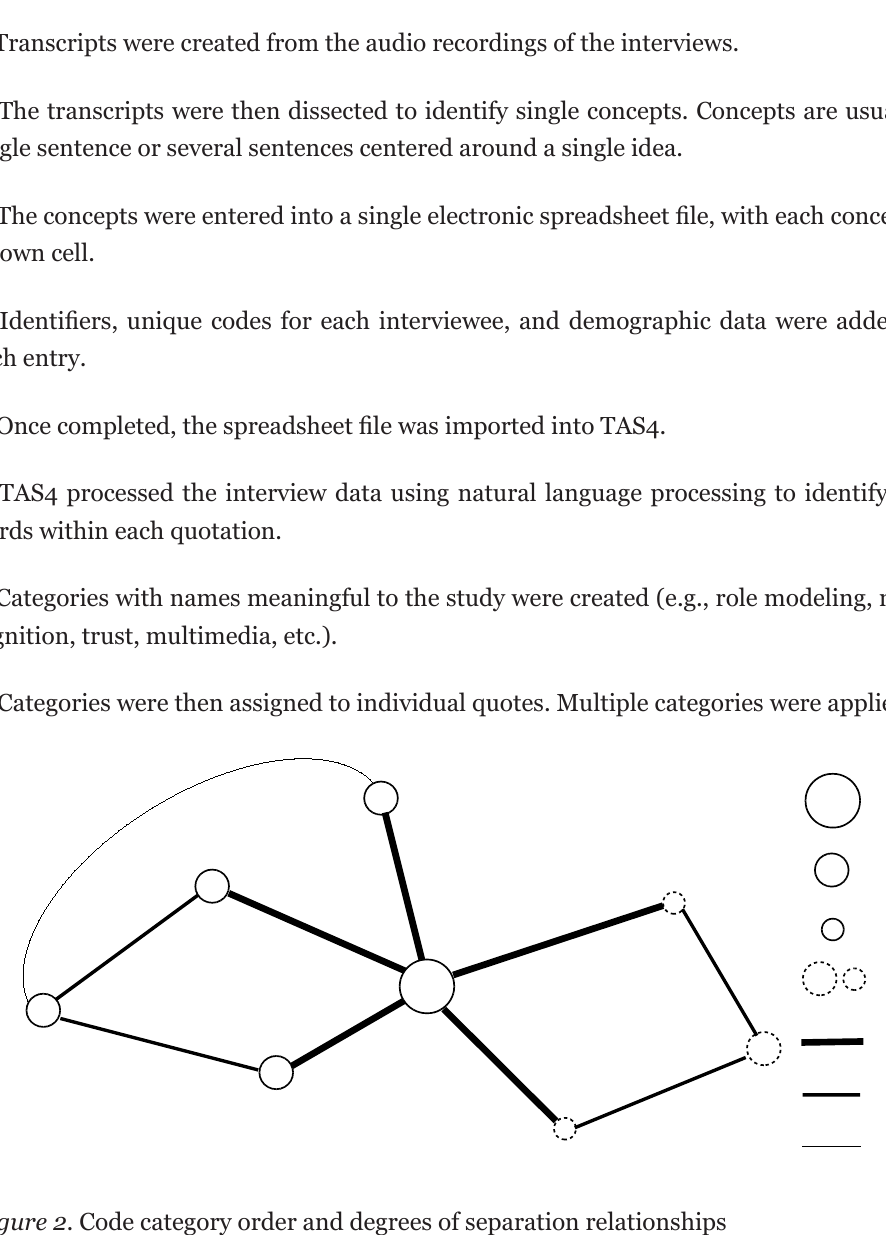
Figure 2. Code category order and degrees of separation relationships appropriate (e.g., the quote “I am not a Facebook person” was assigned the facebook , social support , and perception of others